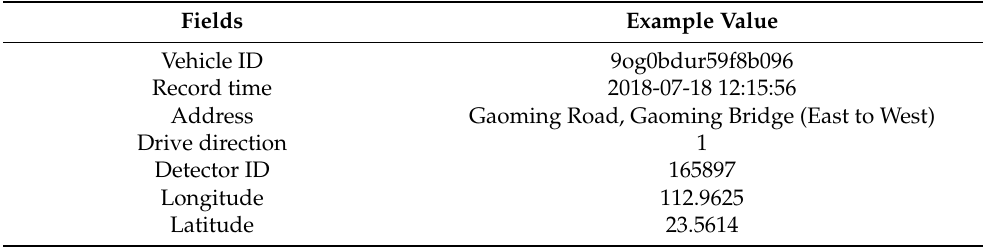
Table 1. Primary fields in the LPR